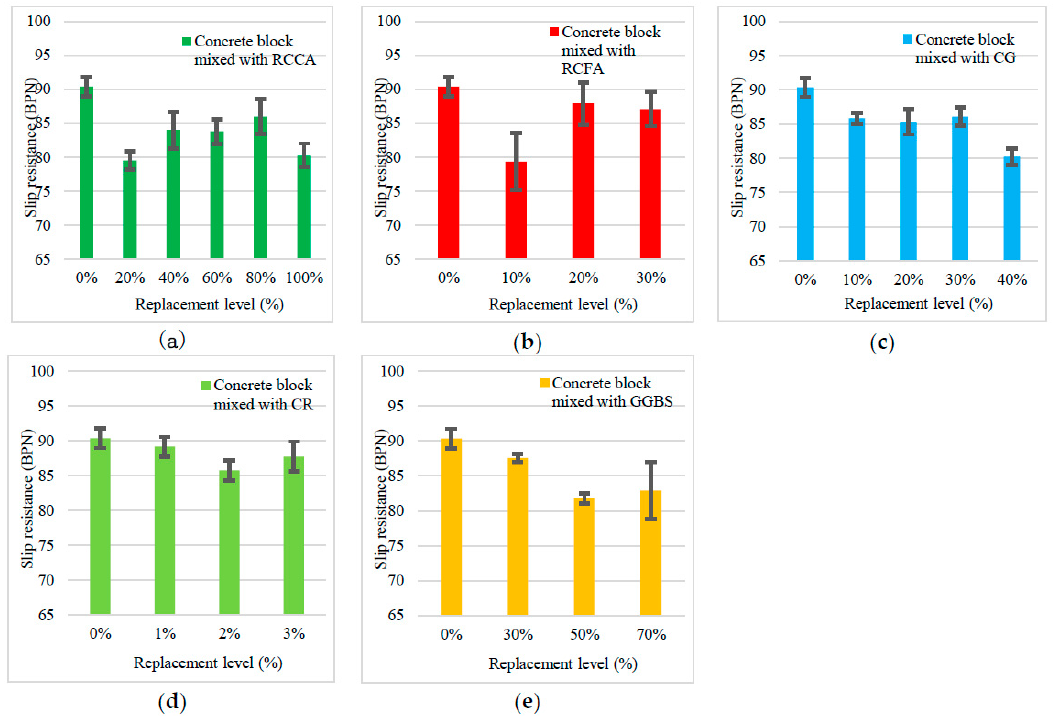
Figure 12. Relationship between the different replacement levels of materials and the slip resistance of specimens. of